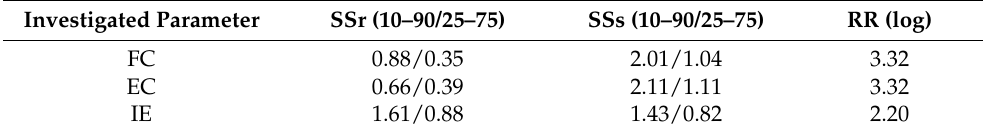
Table 3. 10th and 90th percentile and quartile (25% and 75%) values for FC, EC and IE in the SSr and SSs, and reduction rates for FC, EC and IE (median, logarithmic vs. linear) in SSs in comparison to SSr